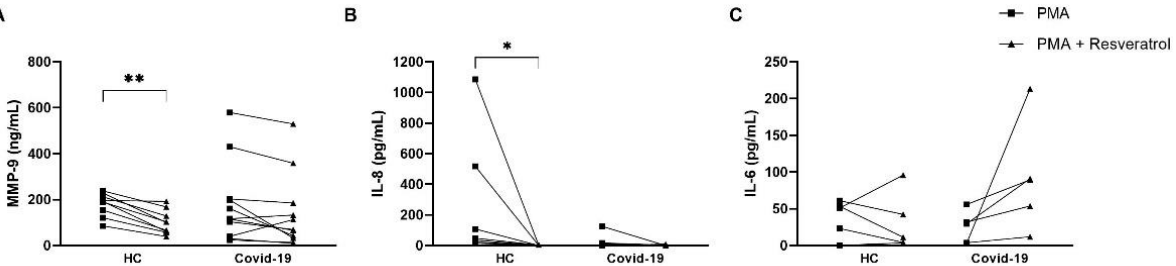
Figure 7. Resveratrol downmodulates cytokine production in PMA-activated neutrophils of healthy donors. Neutrophils (2 × 105 cells/mL) were stimulated with PMA, in presence or not with resveratrol 100 µ M, from healthy controls ( n = 6–9) and severe COVID-19 patients ( n = 5–11). Supernatants of the cultures were determined for ( A ) MMP-9, ( B ) IL-8, and ( C ) IL-6 by ELISA. * p ≤ 0.05, ** p ≤ 0.01.